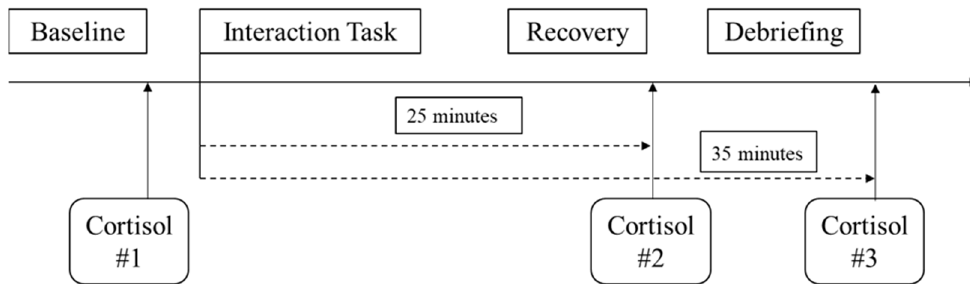
Figure 1. Laboratory Task Protocol and Salivary Cortisol Measurement Timing .